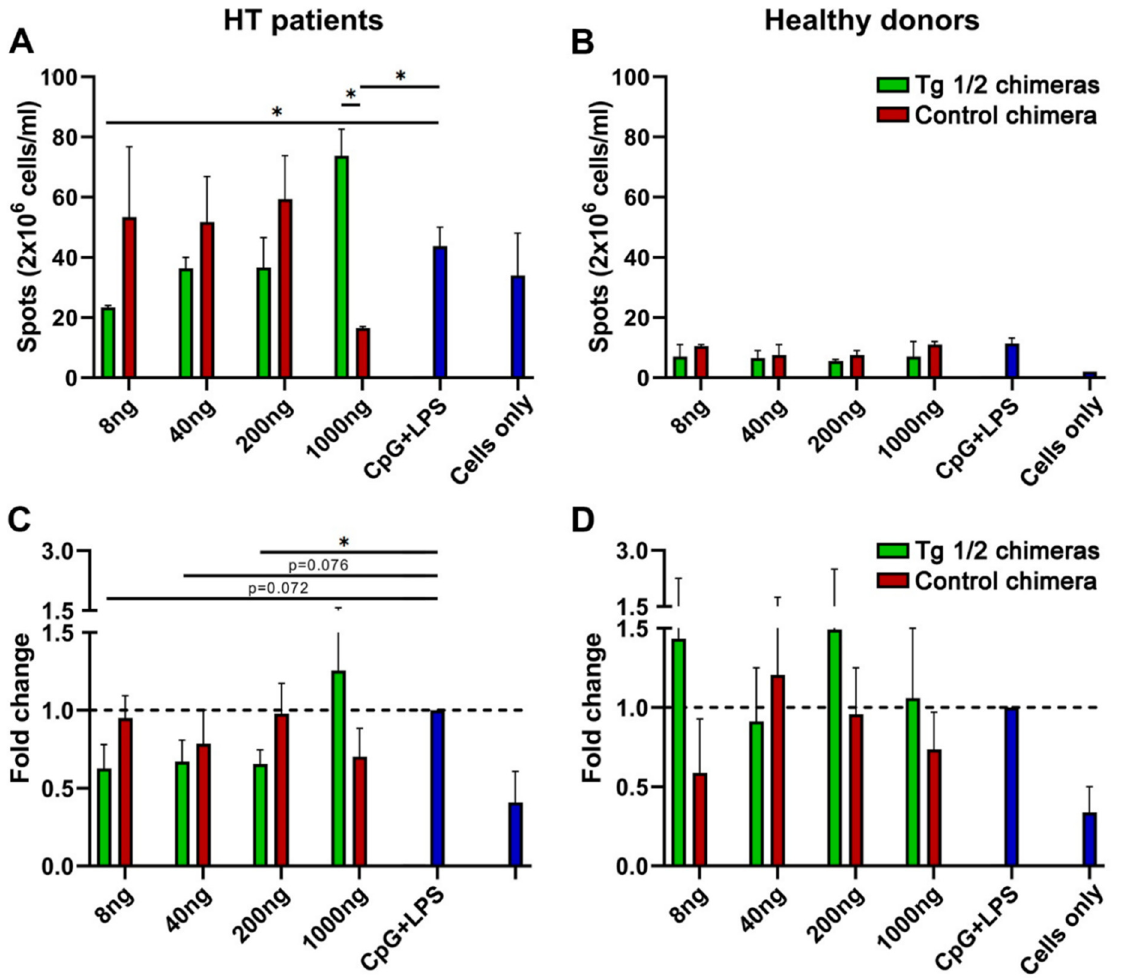
Figure 5. The Tg1/2 chimeras suppressed the Tg-specific B-cell differentiation to anti-Tg antibody- secreting plasmacytes. PBMCs from HT patients ( A , C ) and healthy donors ( B , D ) were cultured with the Tg 1/2 chimeras, or with the Control chimera, or cultured in medium only for 24 h followed by 3 days’ incubation with CpG + LPS or medium only. The number of spots in the test-wells was compared to untreated cells (CpG + LPS control) and determined by ELISpot assay. Results from representative HT patient ( A ) and healthy donor ( B ) are shown. Summarized results for the calculated fold change of 3 independent experiments are presented ( C , D ). All samples were triplicated and average values were used for analysis. Mean ± SD values were calculated for each group; p -values were calculated (* p < 0.05).